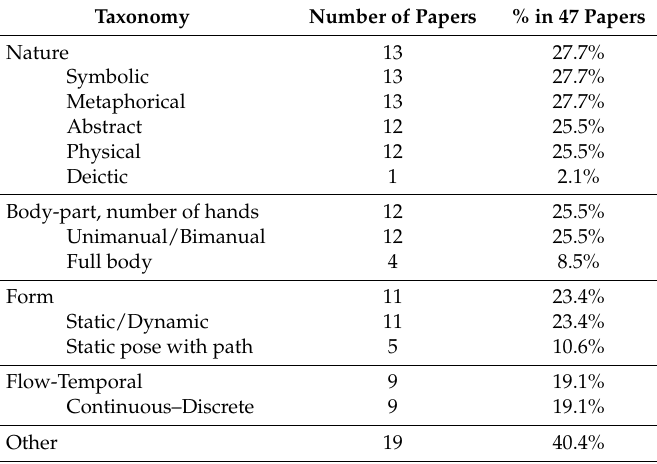
Table 10. Types of taxonomies used in papers